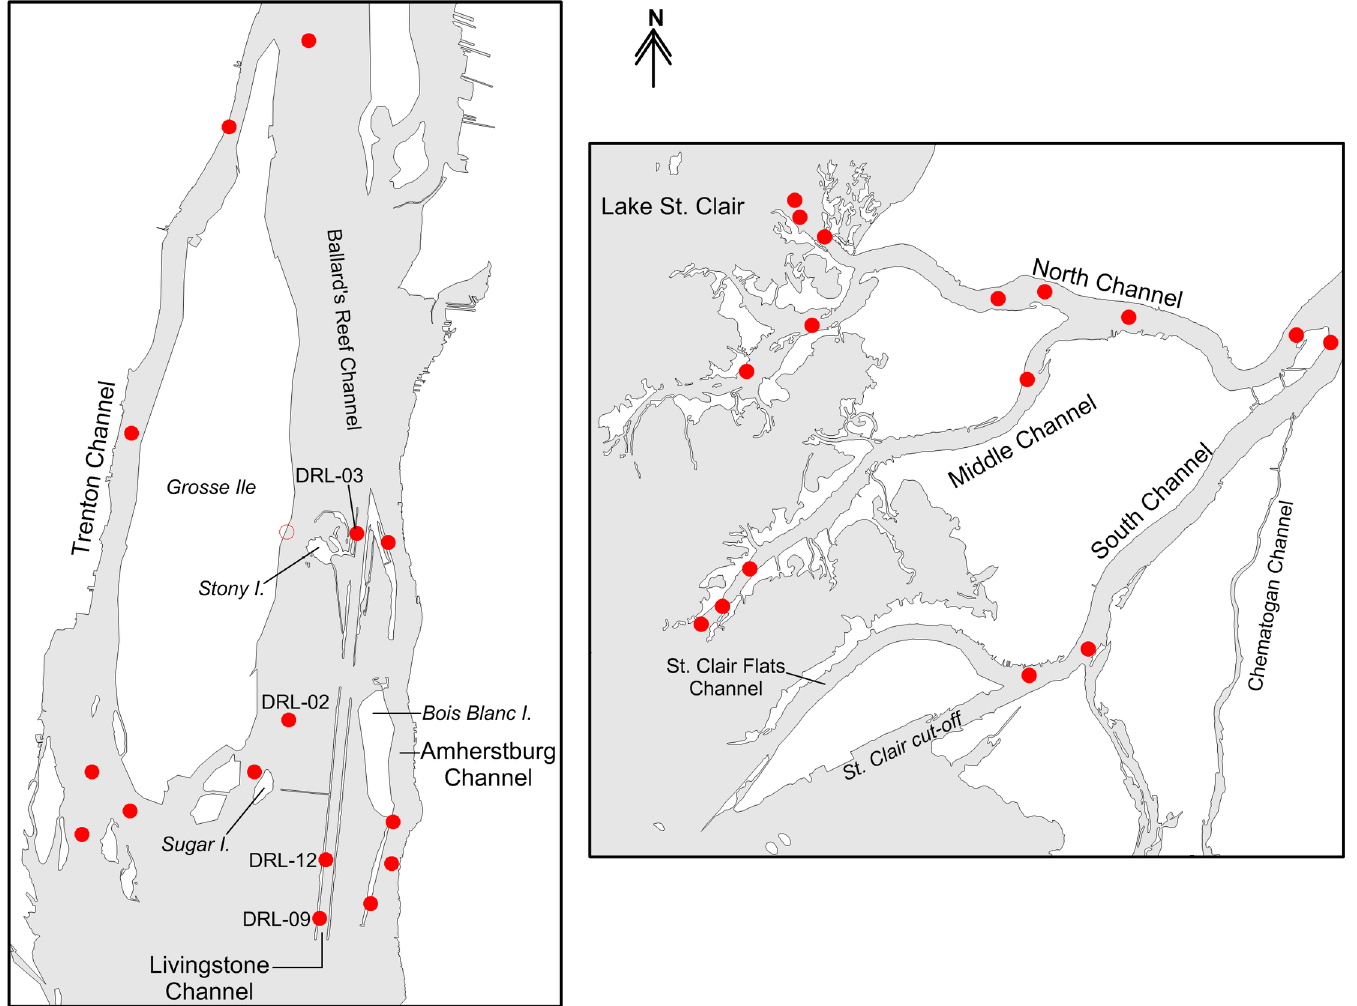
Fig 2. The lower Detroit River (left panel) and lower St. Clair River (right panel). Red circles show locationsof acoustic receivers. The unfilledcircle shows the locationof station DRL-02in 2012. Beginningin 2013, DRL-02was moved to its current location (filled red circle with text “DRL-02”).